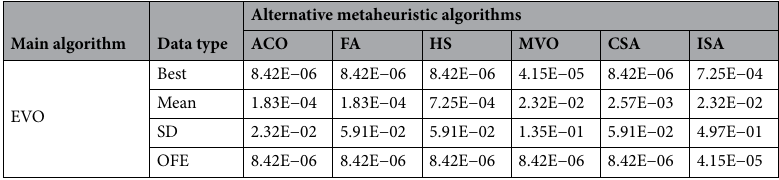
Table 5. The KS test results ( p -values) for different metaheuristic algorithms.